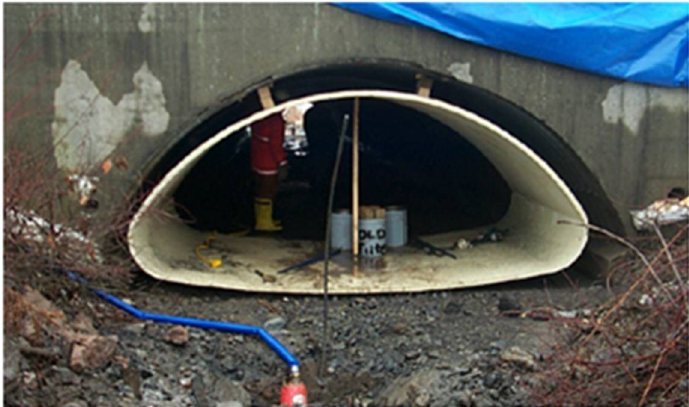
Figure 4. An entire culvert re-lining in Buffalo (USA) using FRP [22].